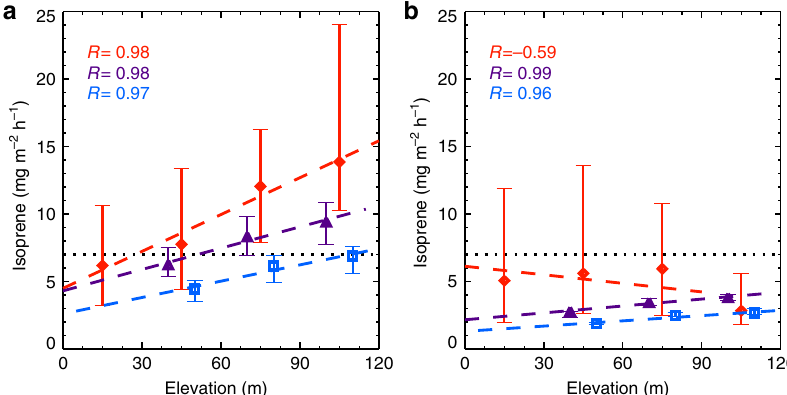
Figure 3 | Correlations of terrain elevations with observed isoprene EFs and top-down isoprene emissions. The median values of isoprene EFs estimated from EC approach (red diamond), top-down biogenic isoprene emissions based on satellite data including GOME-2 (purple triangle) and OMI (blue square), and their 25% quartile values (lower bar) and 75% quartile values (higher bar) during dry ( a ) and wet ( b ) seasons compared with terrain elevations with an interval of 30m. The black dot lines indicate the EF used in MEGAN v2.1. The colour dash lines show linear regressions for median values from each approach, and their correlation coefficients ( R ) are shown in the